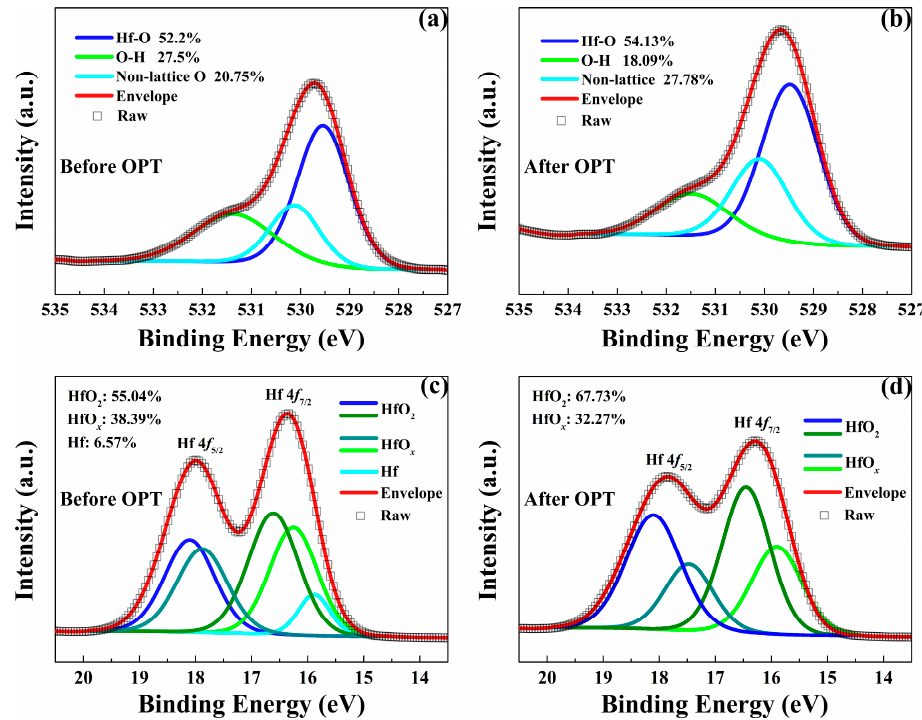
Figure 6. X-ray photoelectron spectroscopy (XPS) spectra of O 1s in the HfO x nanofilm ( a ) before OPT and ( b ) after OPT. XPS spectra of Hf 4f in the HfO x nanofilm ( c ) before OPT and ( d ) after OPT.